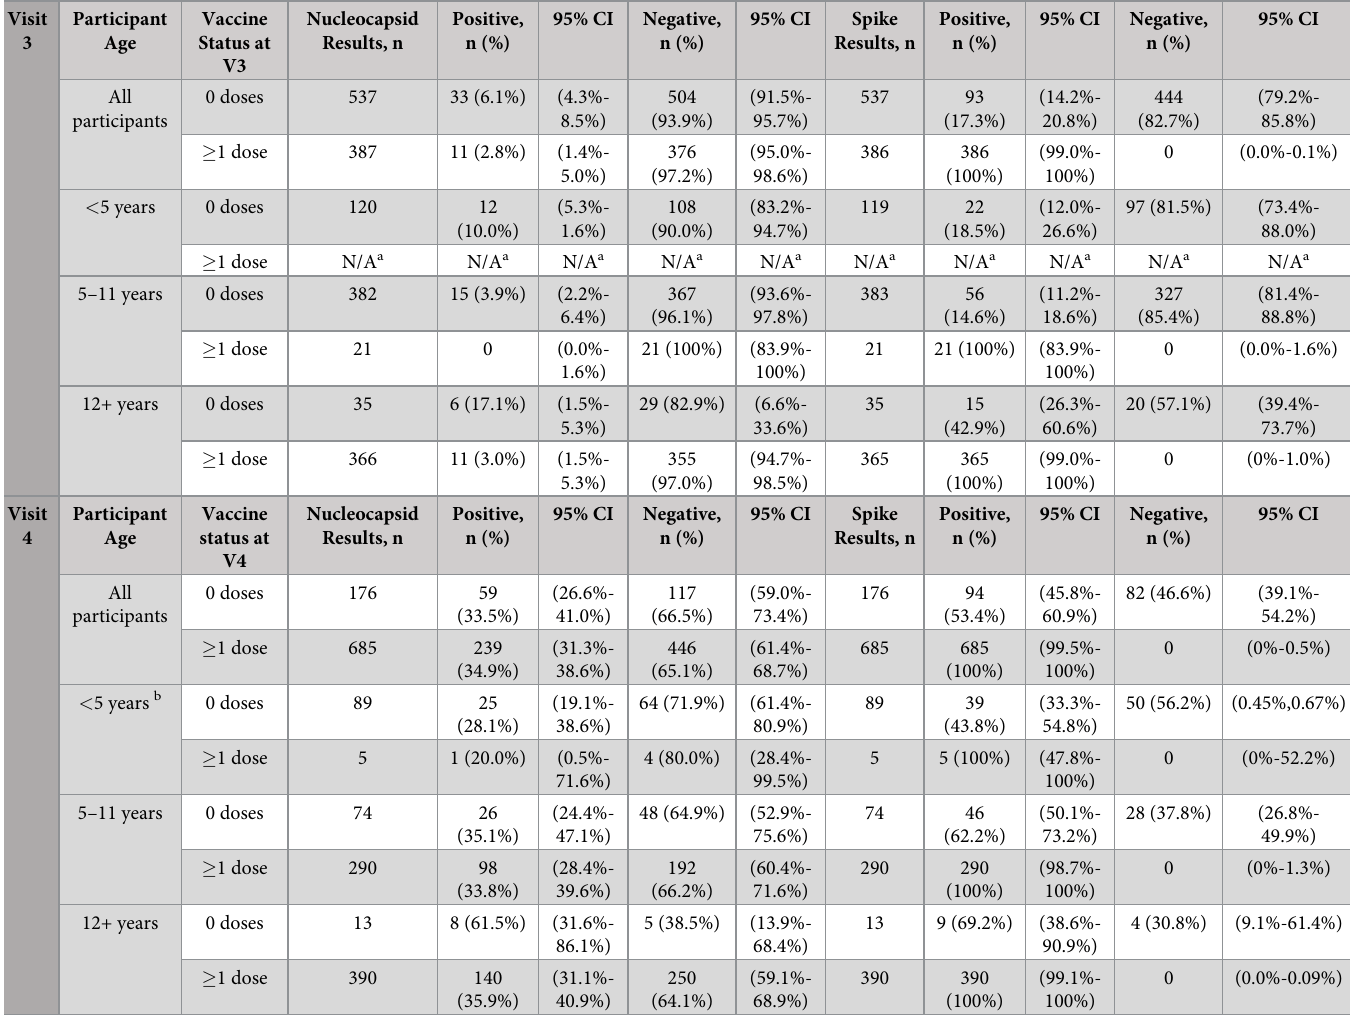
Table 4. Visit 3 and Visit 4 serology results stratified by participant age and vaccine